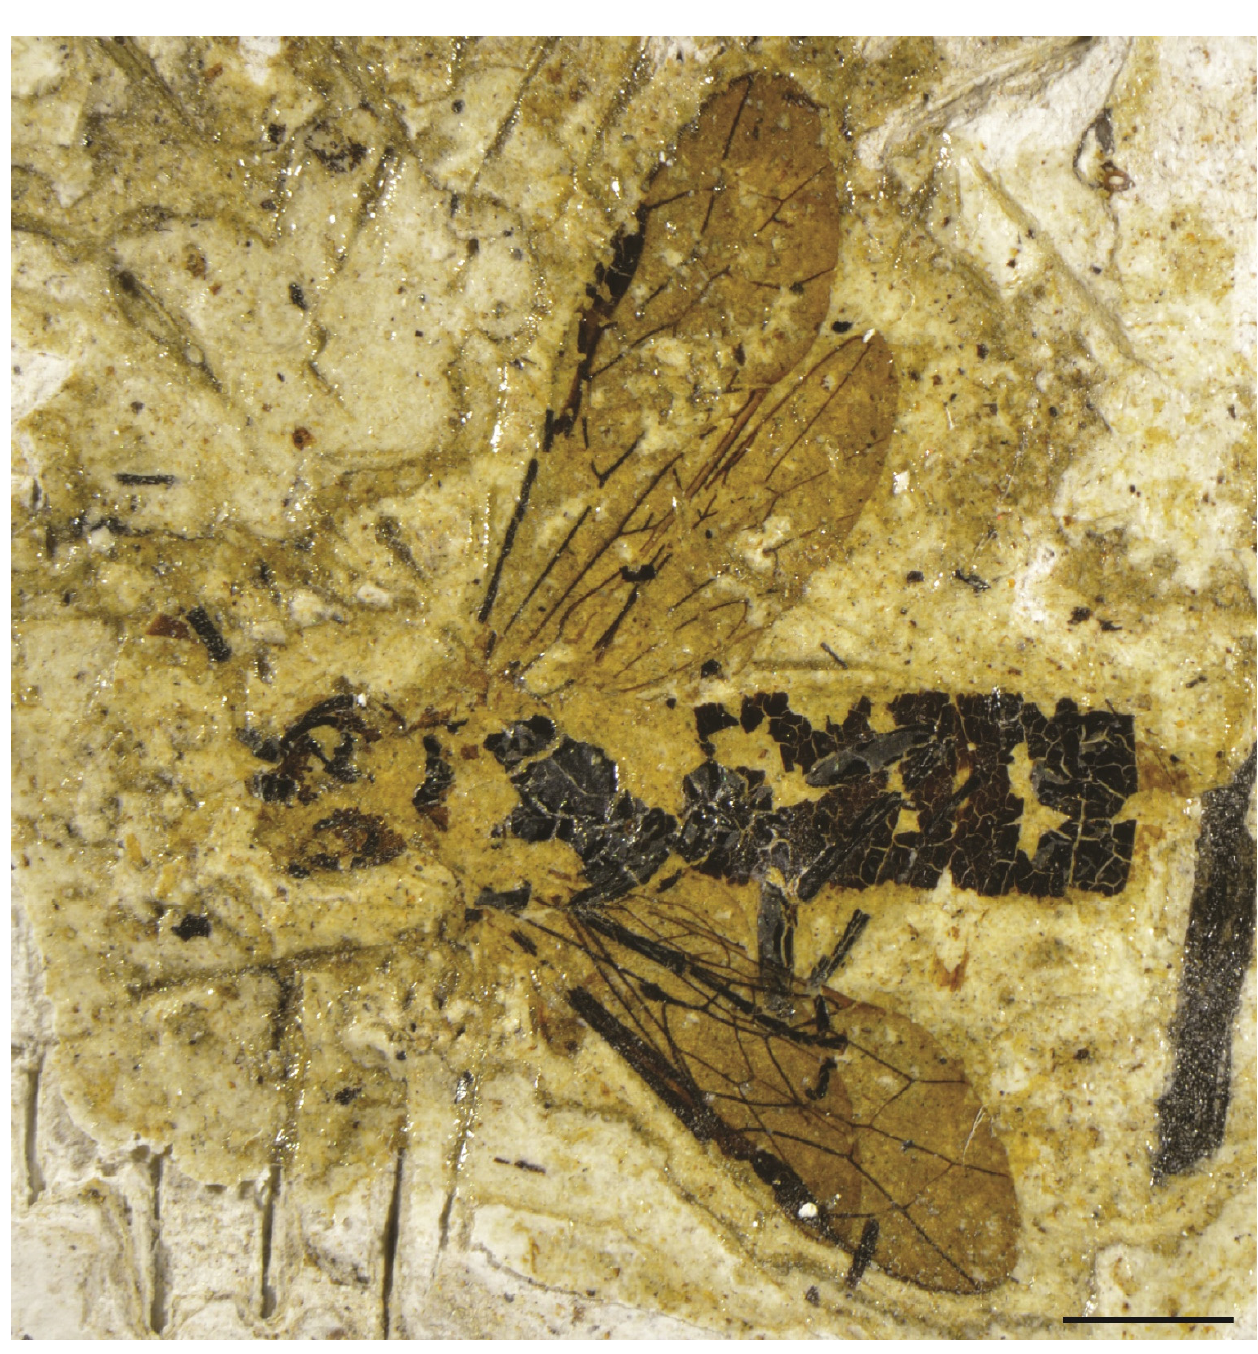
Figure 1. Emphytus miocenicus sp. nov., holotype IGR-PAL-2859. Photograph of general habitus. Scale bar = 2 mm.